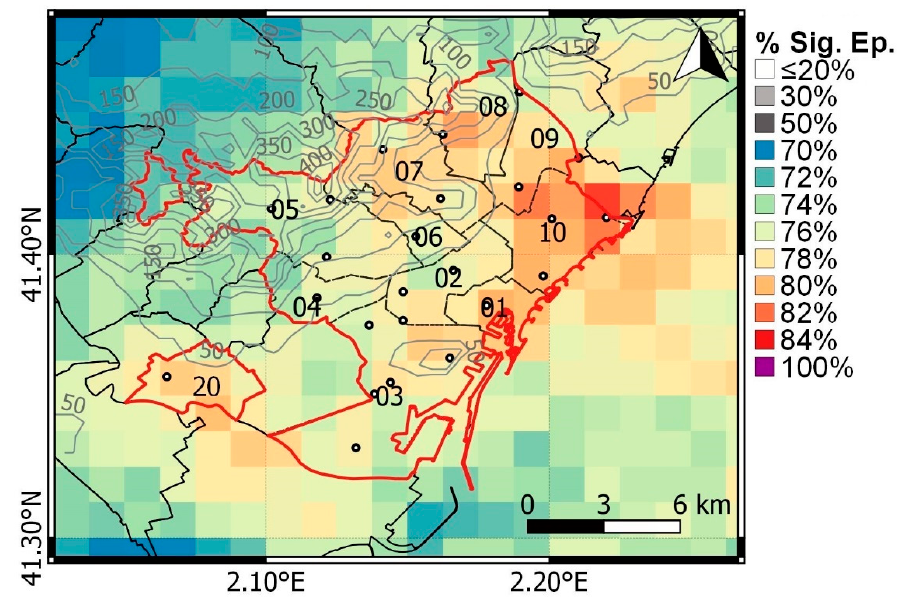
Figure 6. Distribution of maximum surface reflectivity surpassing 30 dBZ. It shows the frequency on each pixel for significant rainfall episodes. The grey contour lines show regions of a constant height (m). The red solid line outlines the ROI. Inside, black solid lines divide the different districts labelled as follows: 01—Ciutat Vella, 02—Eixample, 03—Sants-Montjuïc, 04—Les Corts, 05—Sarri à , 06—Sant